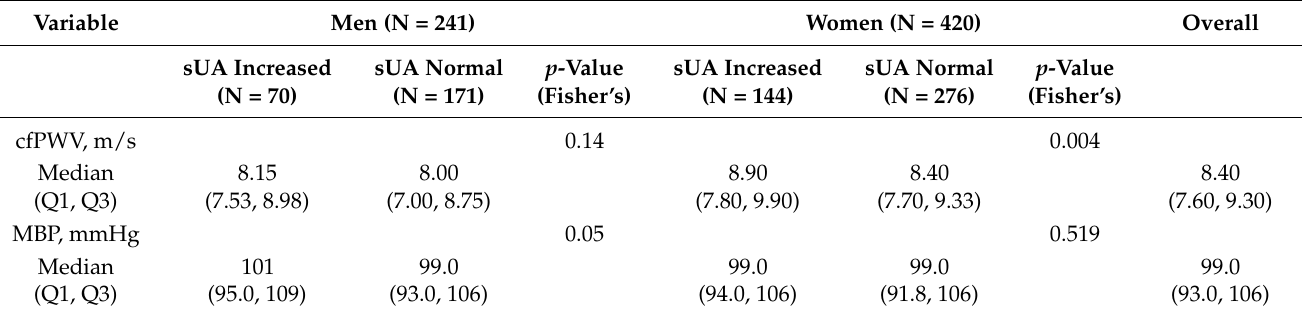
Table 2. cfPWV and MBP characteristics of patients.